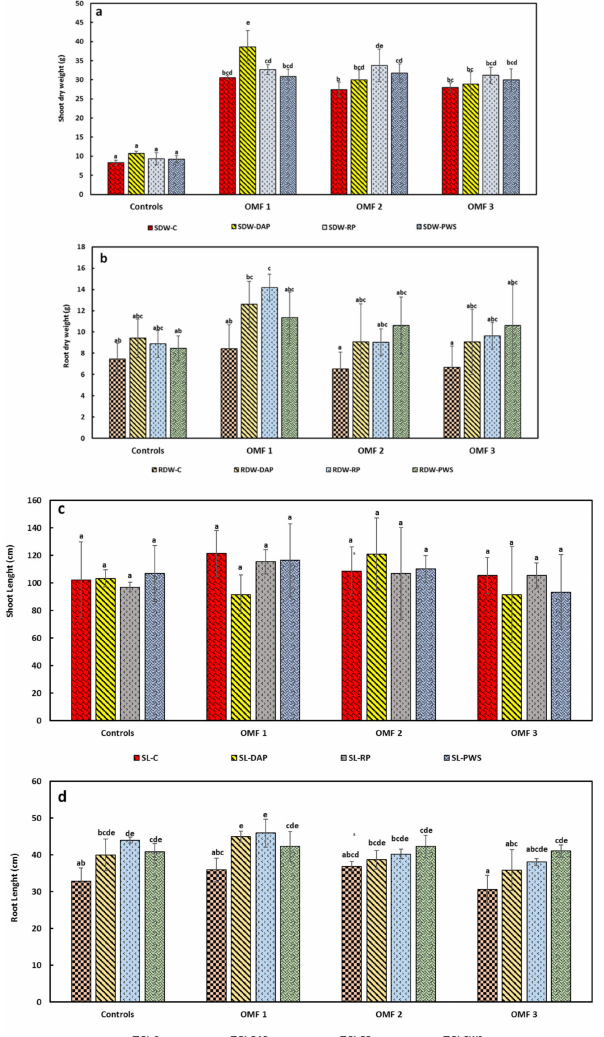
Figure 2. Effect of OMF formulations on plant agro-physiology parameters; ( a ) shoot dry weight (SDW), ( b ) root dry weight (RDW), ( c ) shoot length (SL), and ( d ) root length (RL). Results represent the means ( ± standard deviation) of five replicates. Different letters are significantly different according to Tukey’s test at p <